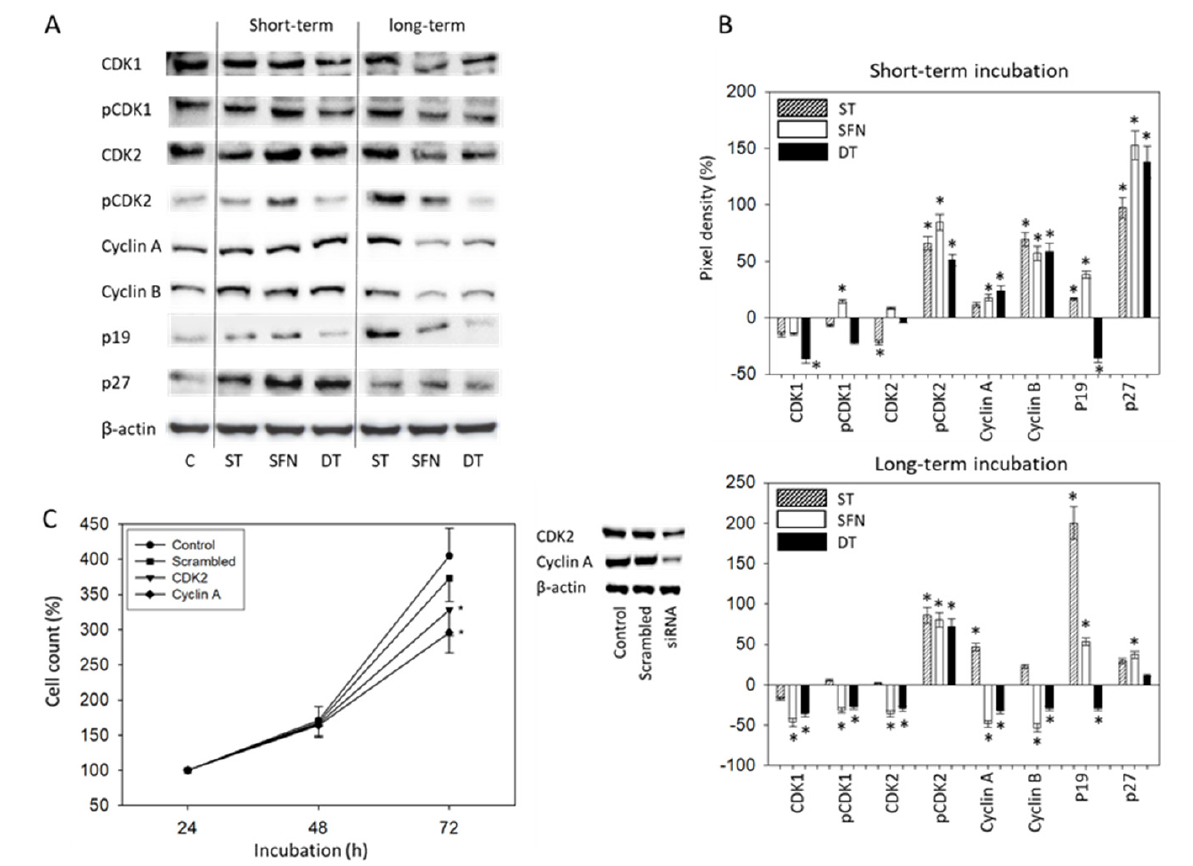
Figure 4. ( A ) Western blot of cell cycle related proteins from 786O lysates. Tumor cells